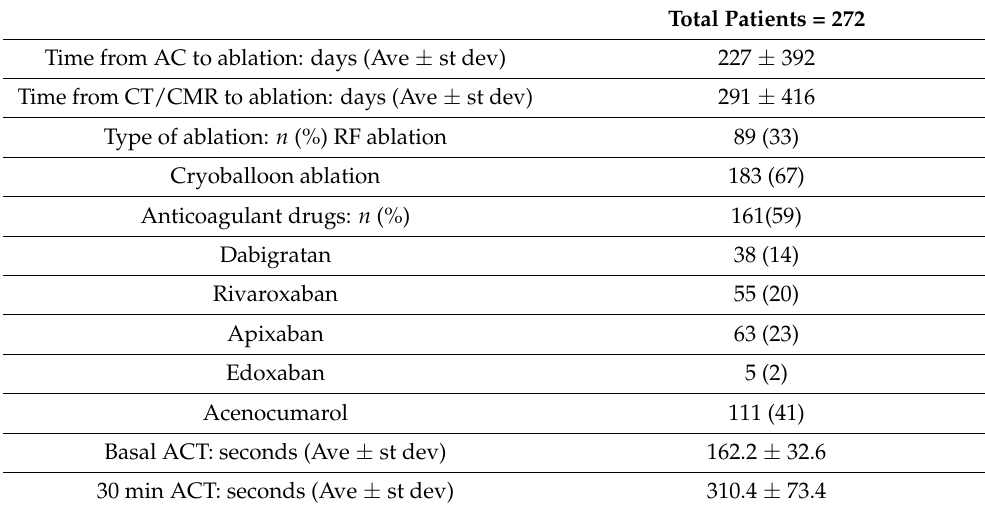
Table 2. Treatment and procedural characteristics.